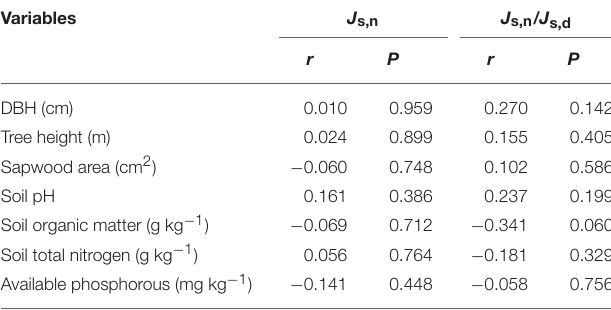
TABLE 2 | Pearson correlation between nighttime sap flux ( J s,n ) and the ratio of nighttime to daytime sap flux ( J s,n / J s,d ) with tree biometric parameters (DBH,